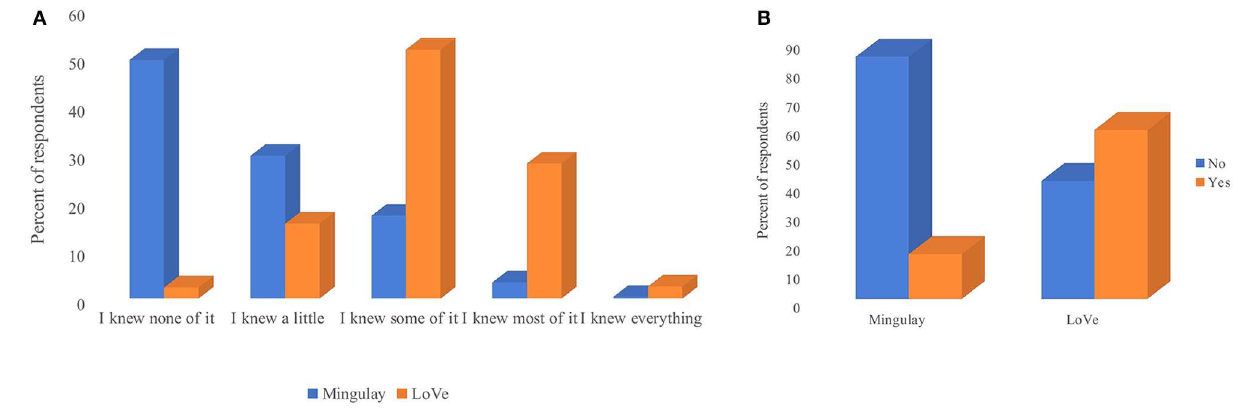
for LoVe was 3.5 (0.81) and Mingulay was 3.6 (0.81) which are relatively similar. A Pearson Chi-square test of independence rejects the null: x 2 ( 5 ) = 145 ( pvalue = 0.00) and shows that the odds (odds ratio = 1.3, excluding the “don’t know” group) of Scottish respondents rating the deep-sea to be in good condition is higher than for the Norwegian